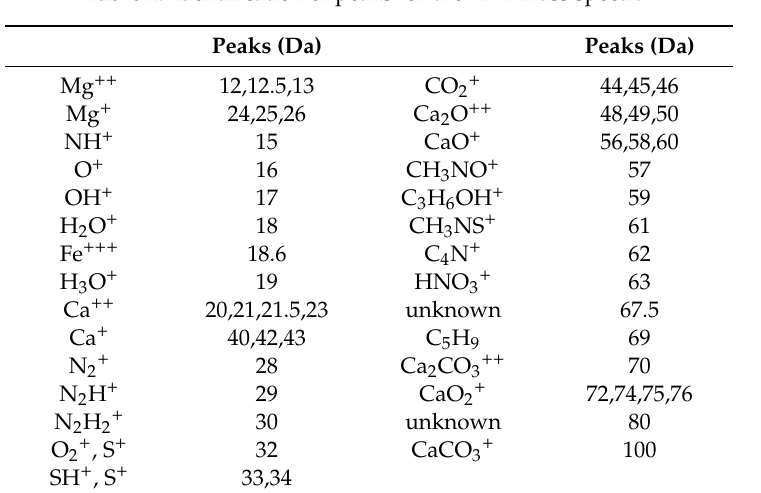
Table 2. Identification of peaks for the APT mass spectra.